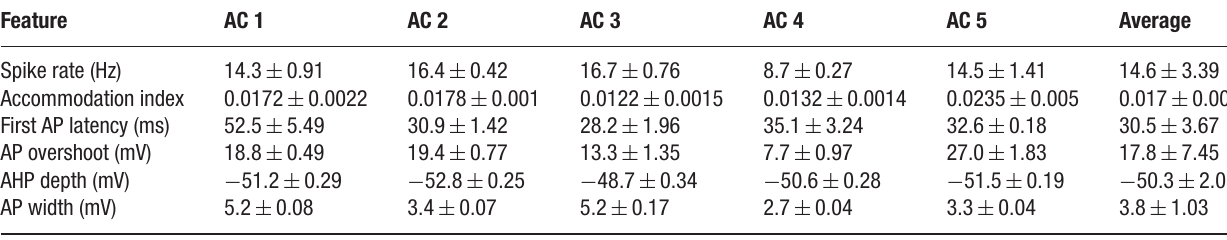
Table 2 . Feature statistics for five accommodating interneurons (current input, 225pA).